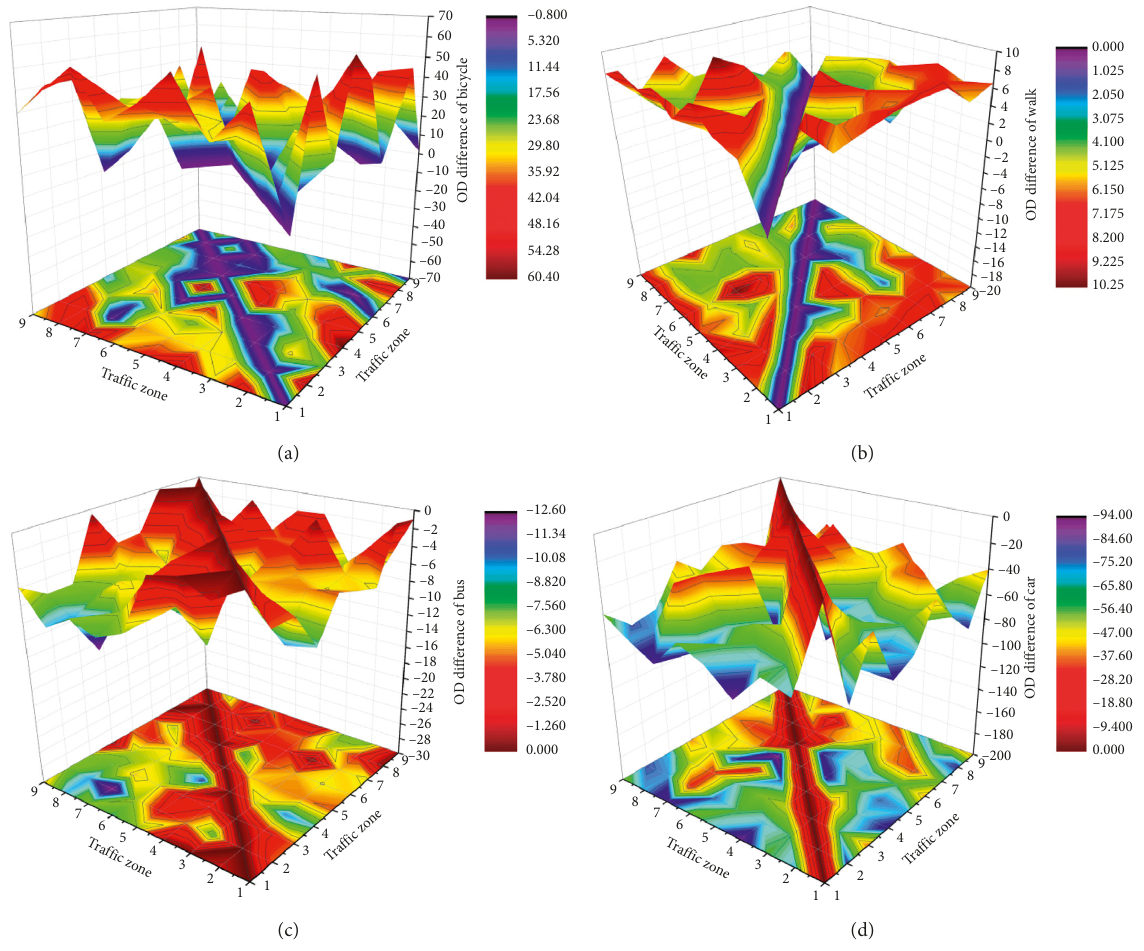
Figure 5: The OD value difference of each travel mode. Table 4: Operational indicators of traffic flow under the two travel